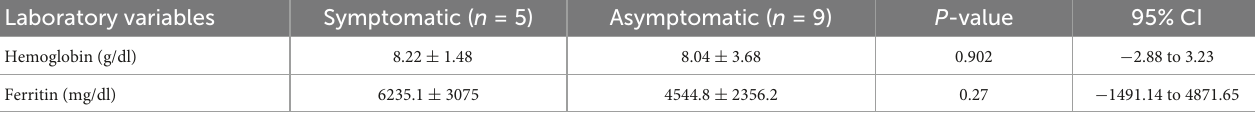
TABLE 2 Laboratory changes in thalassemia children with confirmed